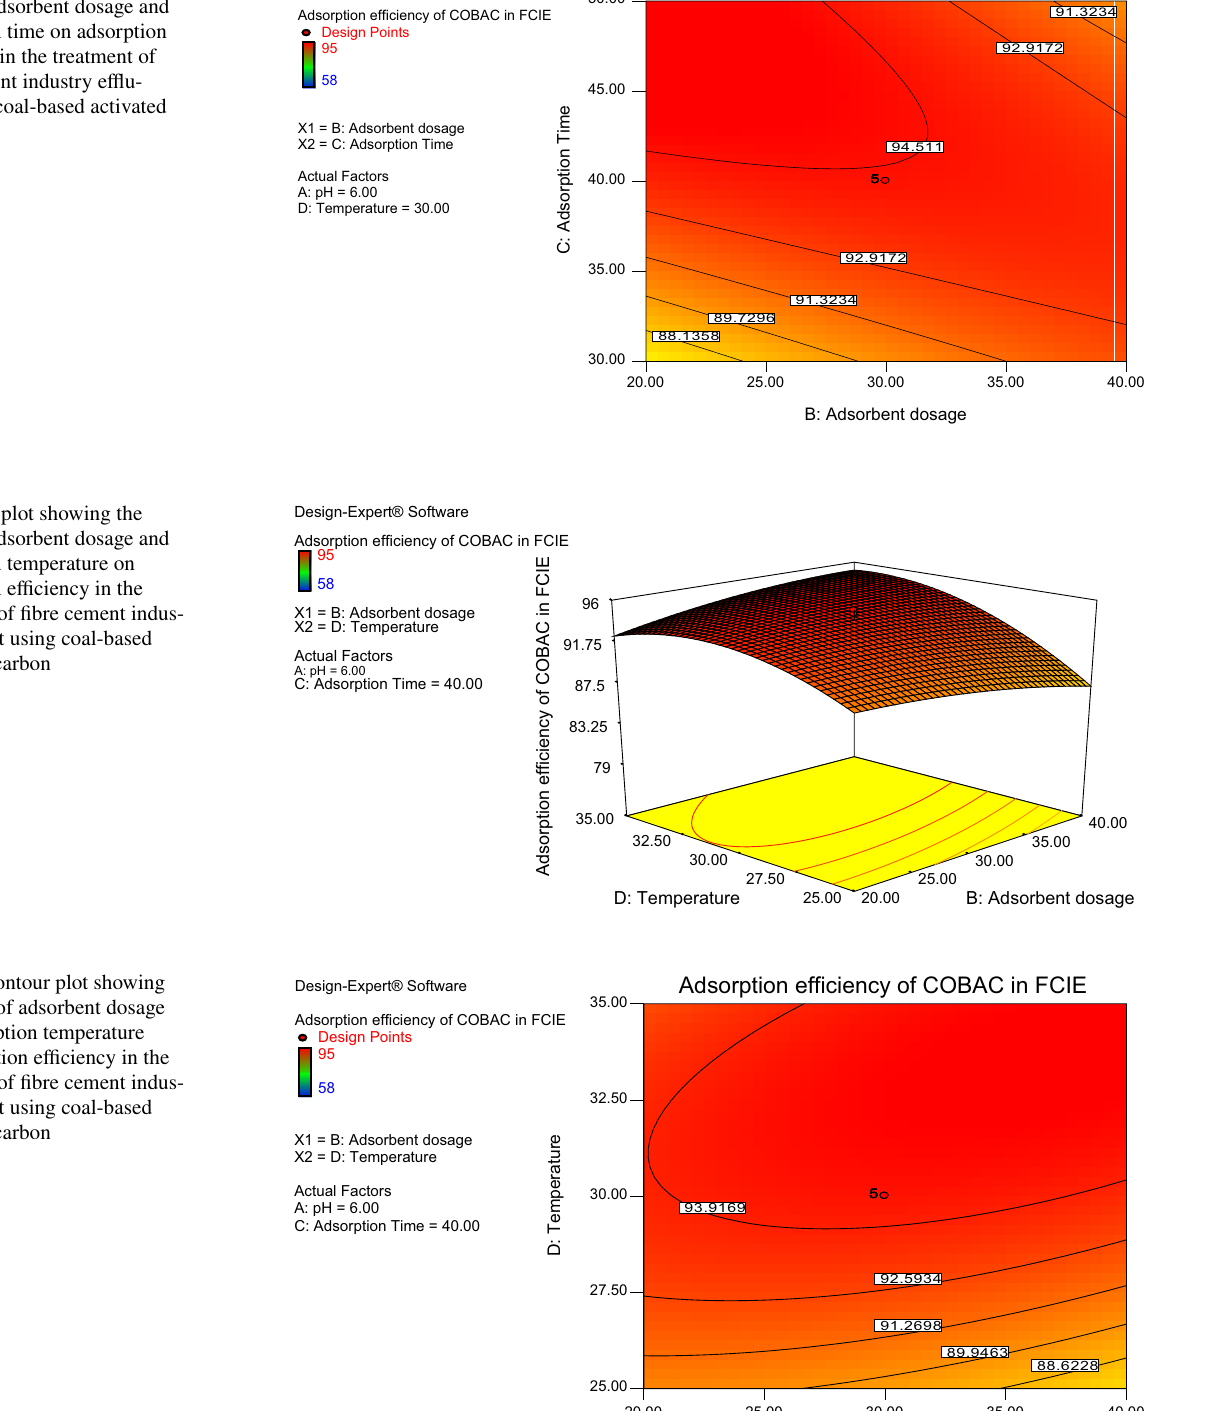
Fig. 8 Contour plot showing the